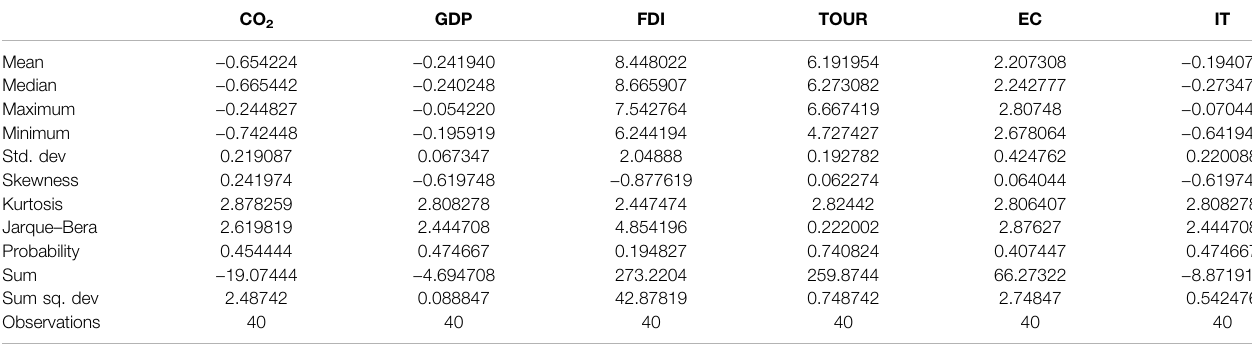
TABLE 2 | Descriptive Statistics of all